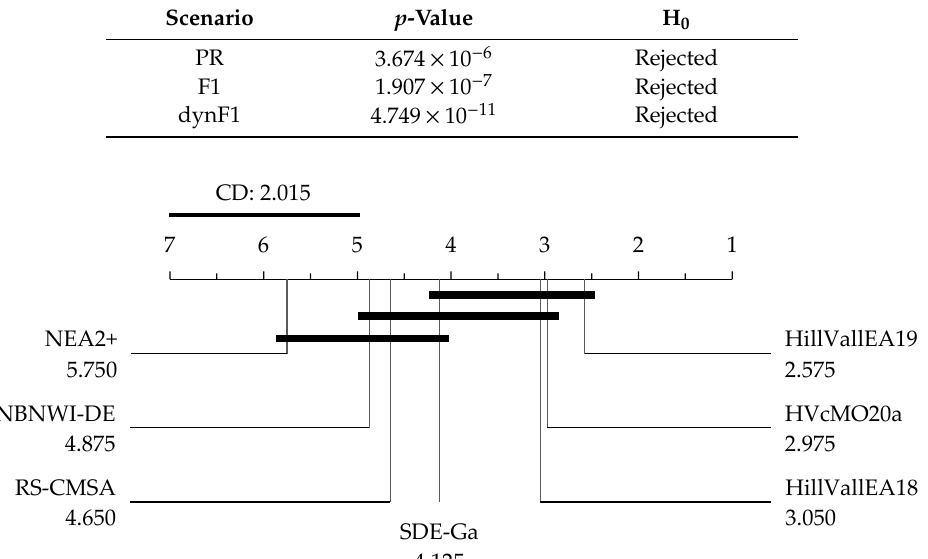
Figure 4. Nemenyi test regarding PR. Connected optimizers are not statistically different.